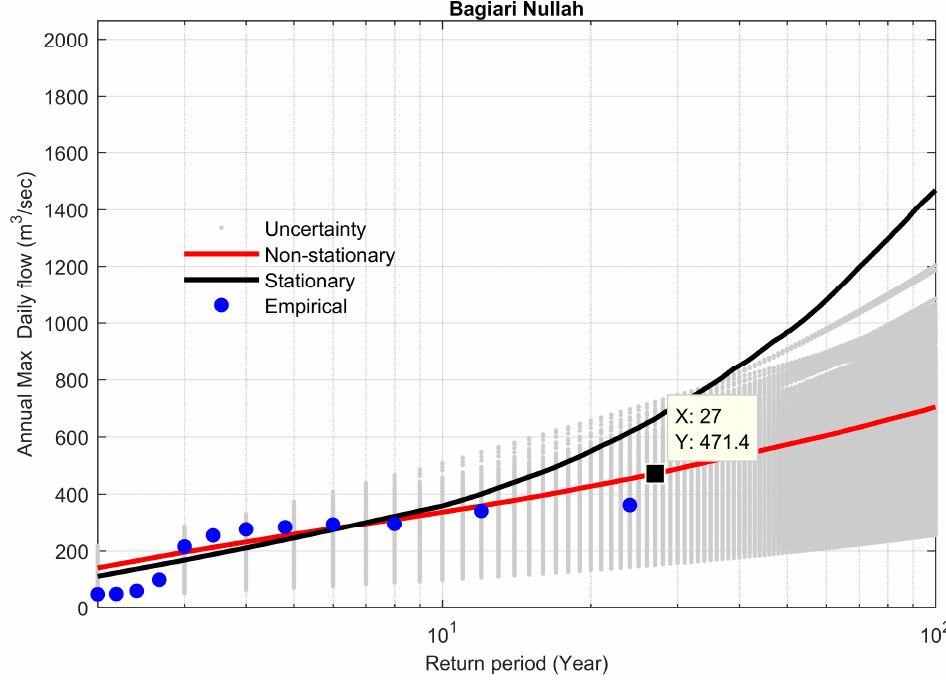
Figure 20. Comparison between non-stationary and stationary FFCs at site 21, along with non-stationary uncertainty bounds for the year 2009.